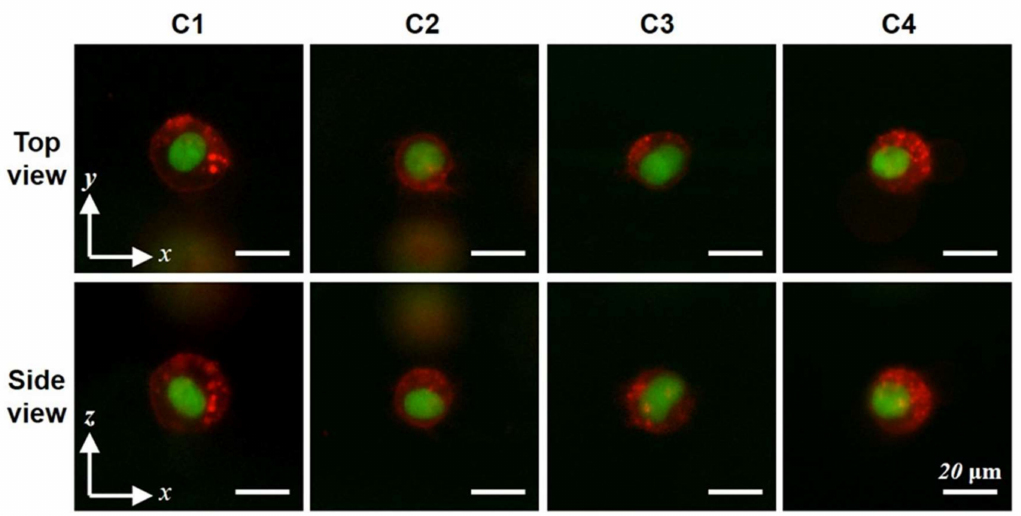
Figure 6. Fluorescent images of subcellular structure from top-view and side-view. Top-view and side-view images (obtained with 40 × objective lens) of four H460 cells with the fluorescent-labeled cell membrane (red) and nucleus